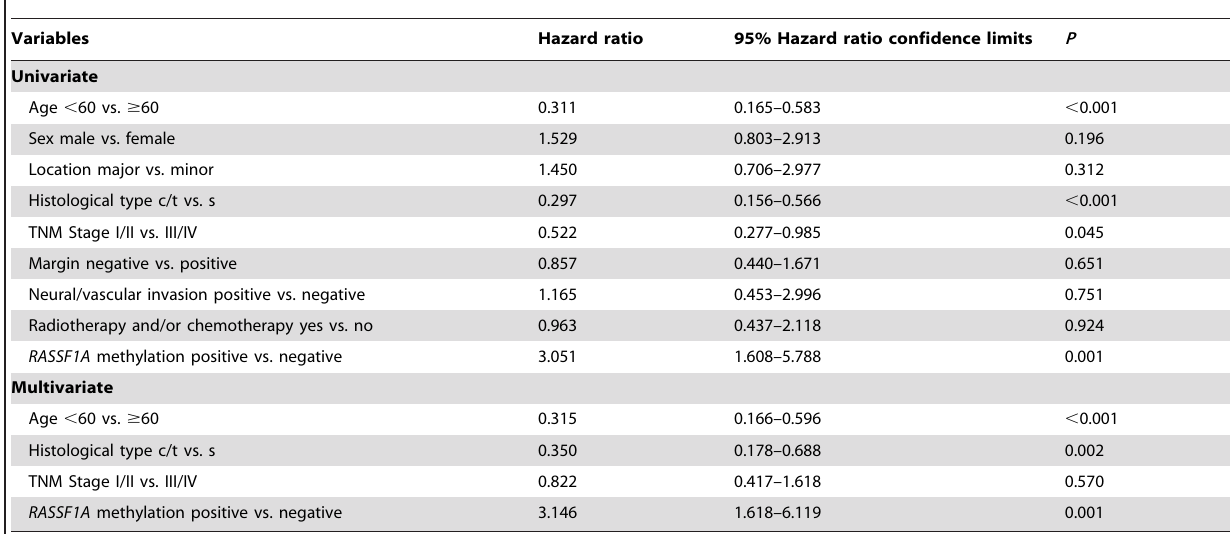
Table 2. Summary of Cox model estimates for over-all survival in 167 patients with ACC.